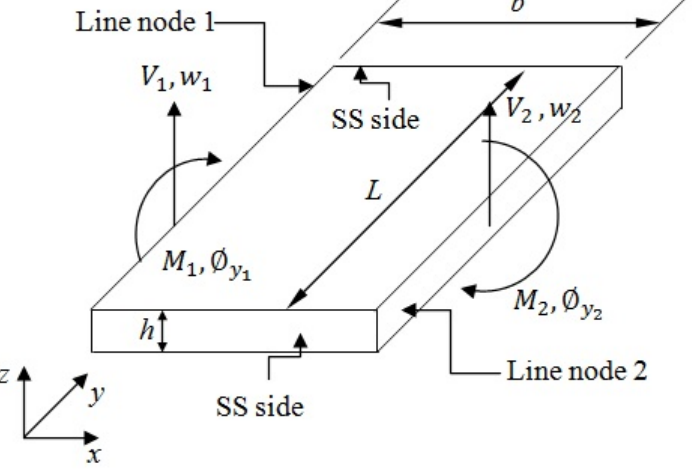
Figure 3. Displacements and force BCs for a plate element.